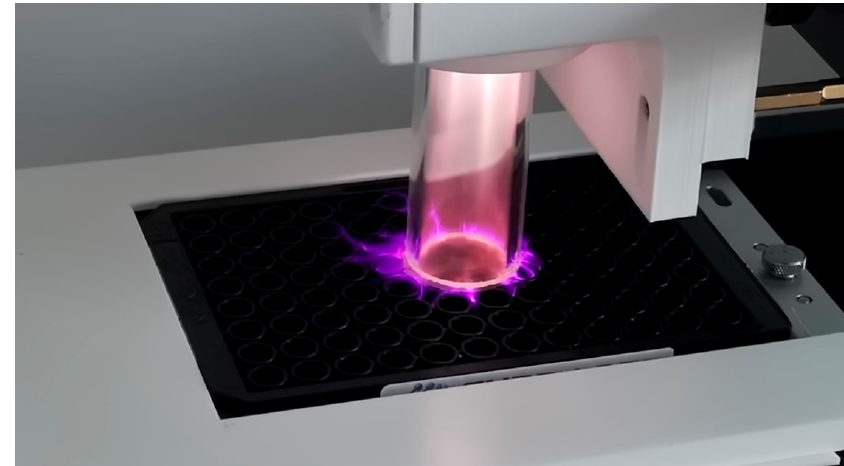
Figure 1. Schematic diagram of plasma deposition system.